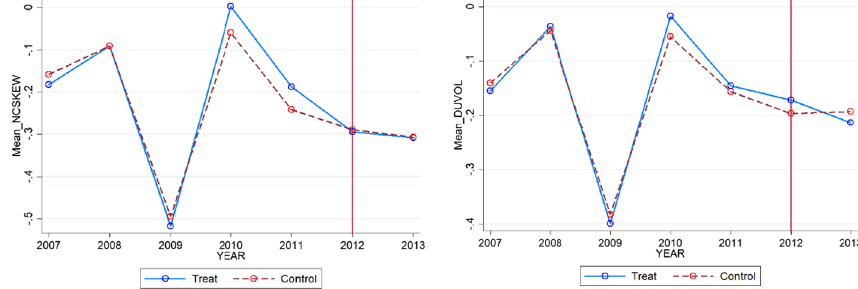
Fig. 5 Stock price crash risk change trend comparison chart